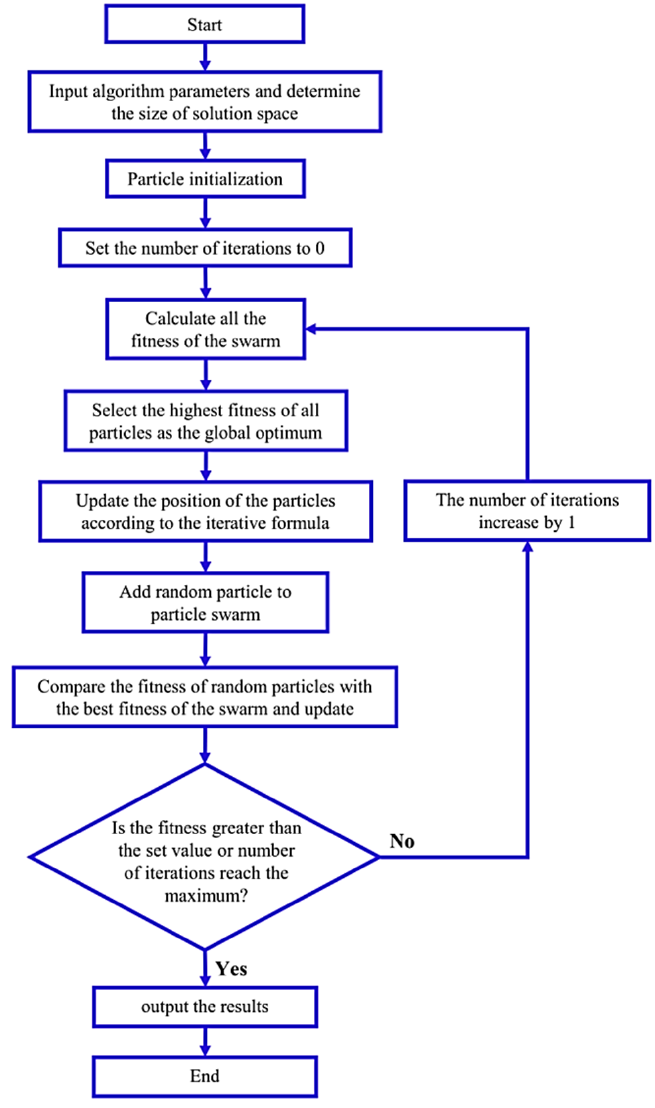
Figure 1. The flow of the ISPSO algorithm.